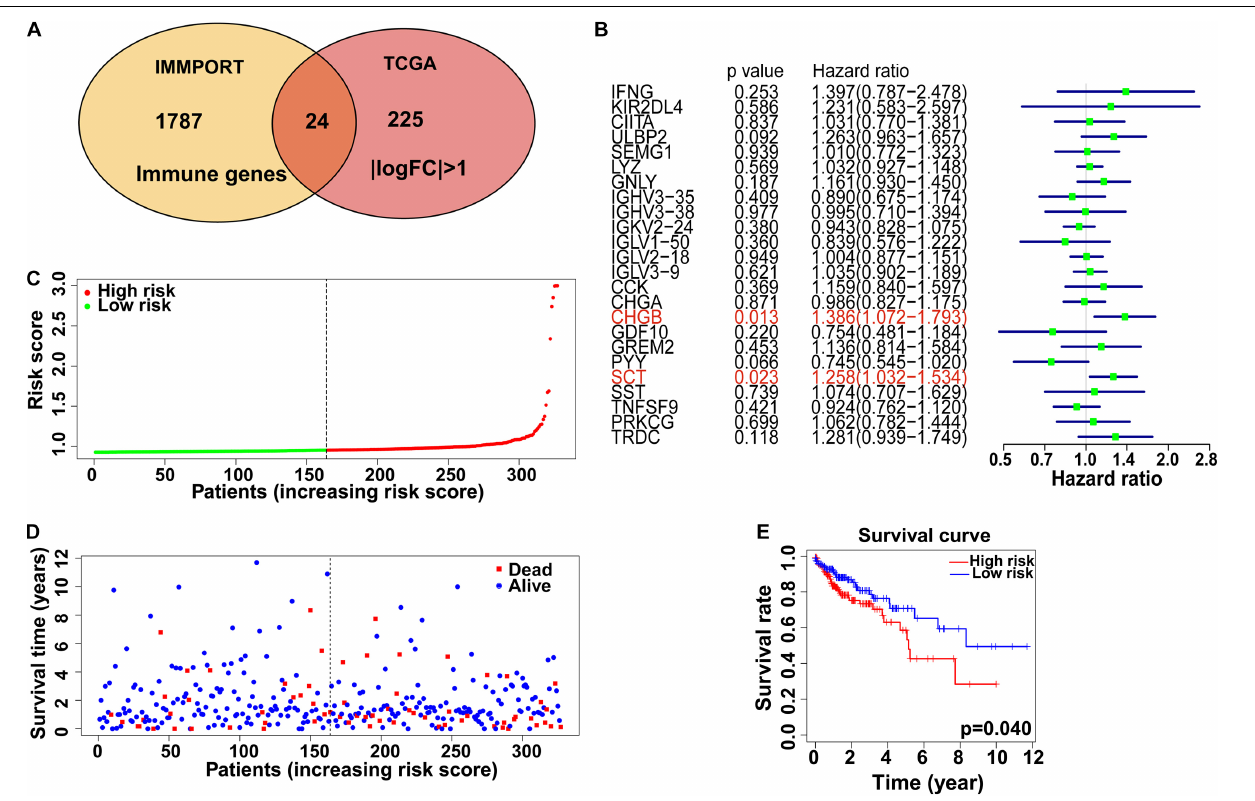
FIGURE 7 | Immune-related genes and relations with colon cancer prognosis. (A) Venn plot shows core immune genes between the Immport and TCGA database. (B) Hazard ratio was analyzed among 24 identified immune-related genes by univariate Cox regression analysis. Two hub genes (CHGB and SCT) indicated significant difference in survival of colon cancer patients. (C) Immune risk score calculated for each colon cancer patients. Patients were divided into high risk and low risk group by median risk score. (D) The survival time of different colon cancer patients. (E) Low immune risk group showed better 5-year survival than High risk group.